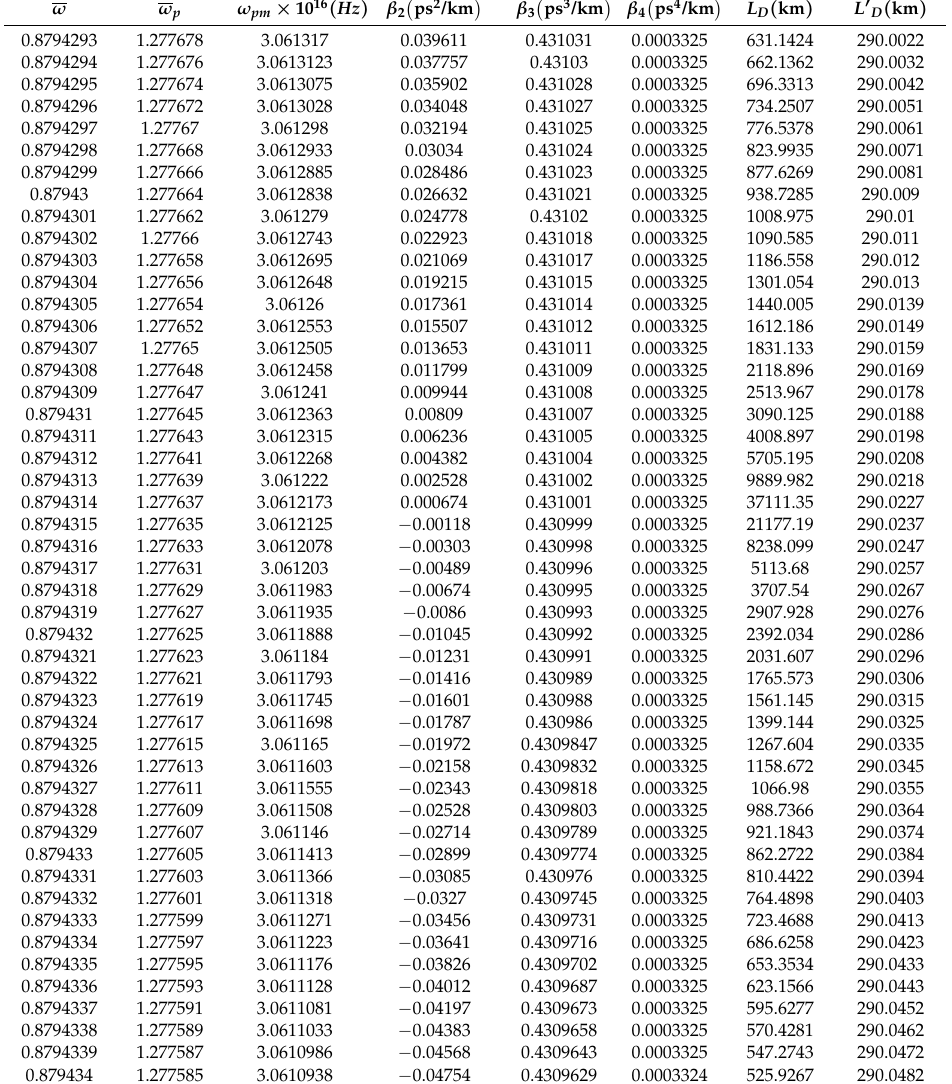
Table A1. All points in Figure 7 with L D ≥ 525.93 km and L (cid:48) ≈ 290